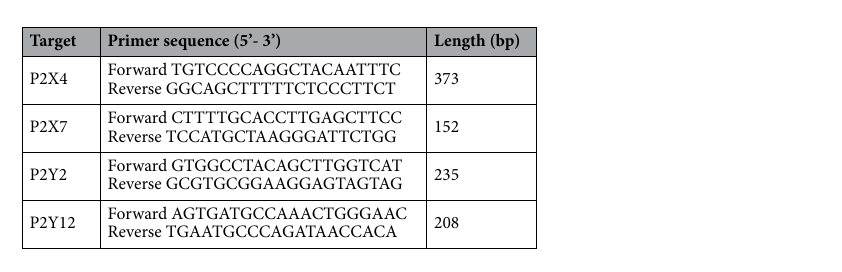
Table 3. Primer sequences for PCR